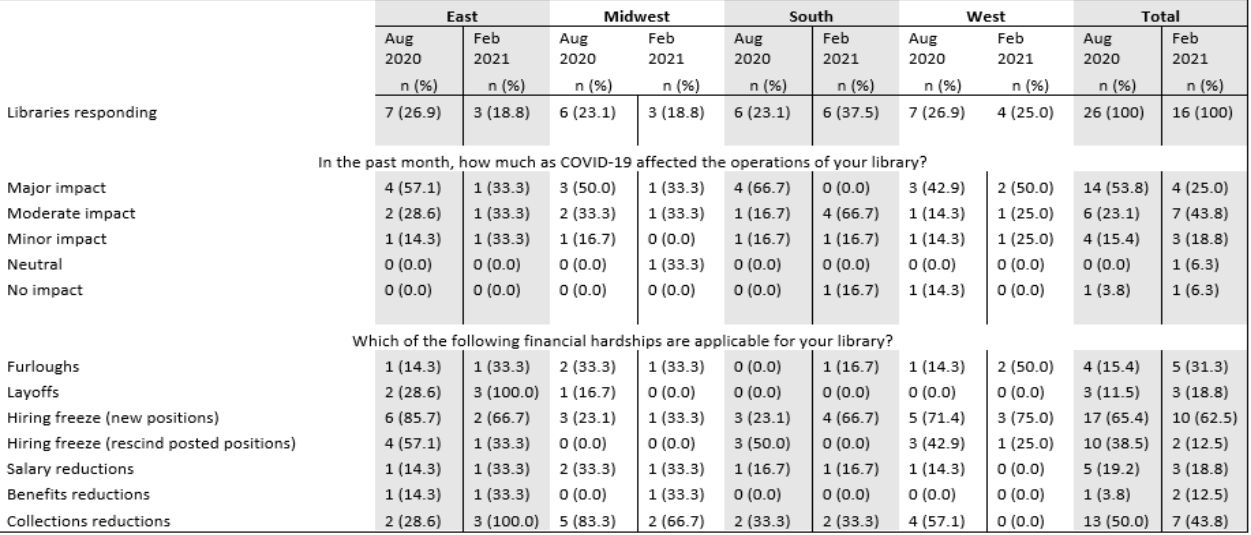
Table 2 Impact of COVID-19 on library operations, finances, and staffing by region, comparing August 2020 and February 2021 responses.